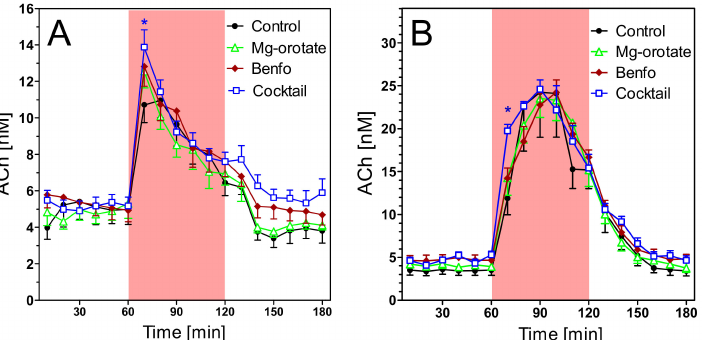
Figure 9. Extracellular ACh concentrations in hippocampus of young (6–7 months old) wild-type rats during during open field test ( A ) and under scopolamine perfusion ( B ). The rats were submitted to four different treatments for 14 days: no treatment (“control”), magnesium orotate, benfotiamine and cocktail. The red area represents the intervention (open field exposure or scopolamine perfusion) from 60–120 min. Data are means ± SEM ( n = 8–9) and were analysed by two-way ANOVA for treatment as variable followed by Bonferroni’s multiple comparison test: ( A ) F3,527 = 1.02, p = 0.47, * p < 0.05. ( B ) F3,527 = 0.77, p = 0.78. * p <